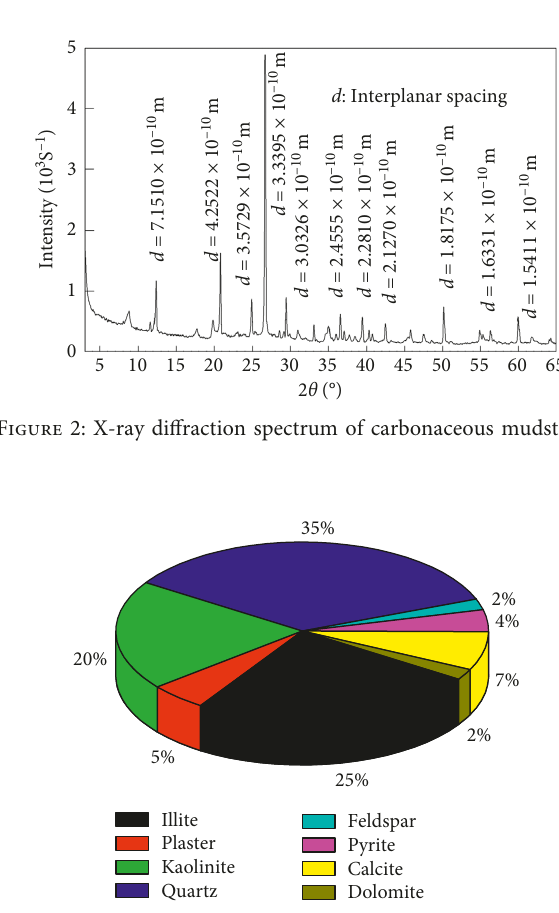
Figure 1: Failure mode of carbonaceous mudstone. (a) Cracking type. (b) Carbonaceous mudstone after disintegration.